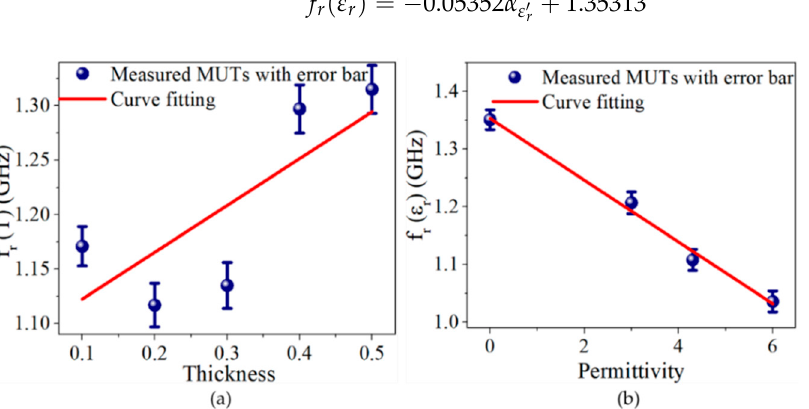
Figure 10. ( a ) Linear regression graph as per change in MUTs thickness with error bar indicating an excellent linear response ( r 2 = 0.91567); ( b ) linear regression graph as per change in MUTs permittivity with error bar indicating an excellent linear response ( r 2 = 0.98903).